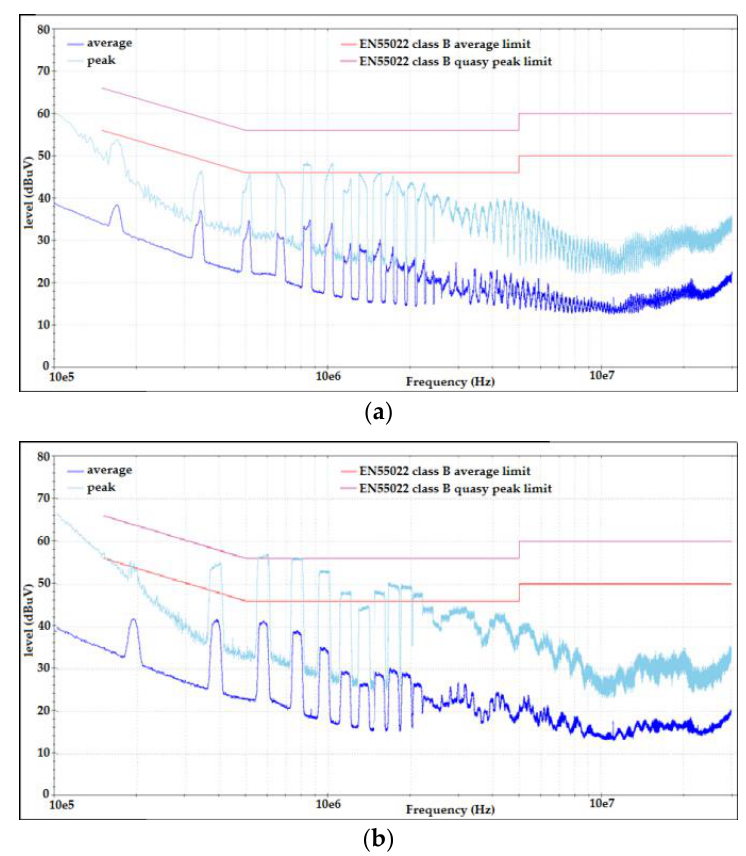
Figure 10. EMI results for average, dark blue and peak, light blue values. Upper limit: quasi peak, lower limit: average. ( a ) Result at 115 Vac, full load and ( b ) result at 230 Vac, full load.